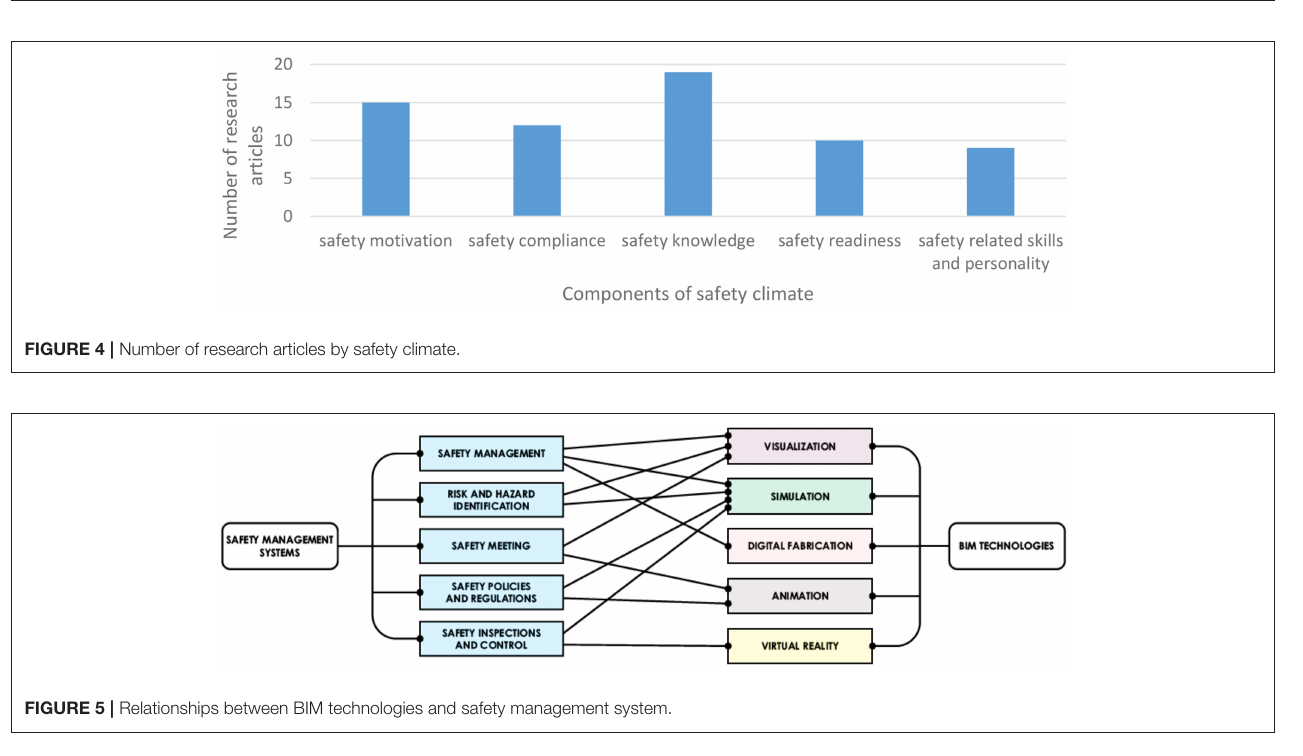
FIGURE 3 | Number of research articles by safety behavior.